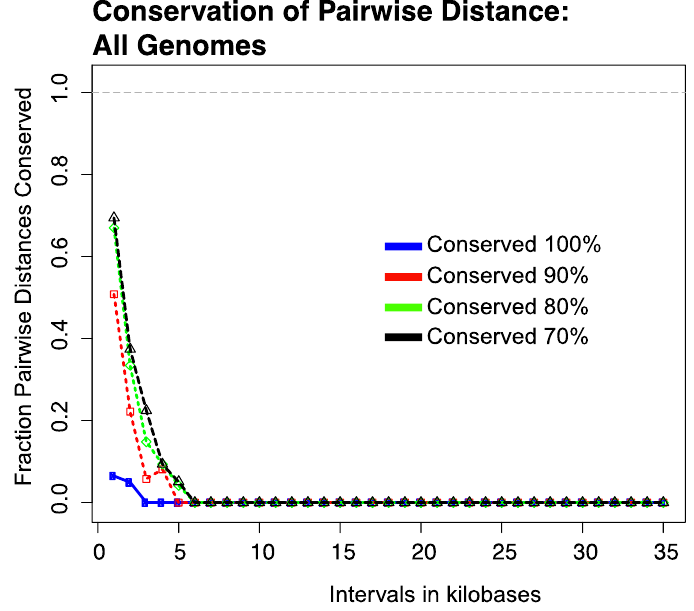
Figure 2. Analysis of pairwise conservation of Single Copy Core Gene (SCCG) distances in 1000-bp bins analyzed for all Chlorovirus genomes. The SCCG set determined for all genomes is used to determine the degree to which distances between specific pairs of SCCG are conserved across all genomes. Distances are considered to be conserved if they fall within the same 1000-bp size bin (e.g., 2000–3000 bp, 5000–6000 bp, etc). Each data point on the x -axis represents the upper bound of the bin size. The first data point ( x = 1) represents an analysis of pairwise distances in a search genome between 0 and 1000 bp while the tenth data point ( x = 10) represents an analysis of pairwise distance in a search genome between 9000 and 10,000 bp. Specific pairwise distances (assigned to a unique pair of SCCGs) in a search genome are searched against all other genomes. The y-axis reports the fraction of the pairwise distances considered in the size bin in question that were conserved in 100% (blue line), 90% (red line), 80% (green line), and 70% (black line) of all other genomes, respectively.